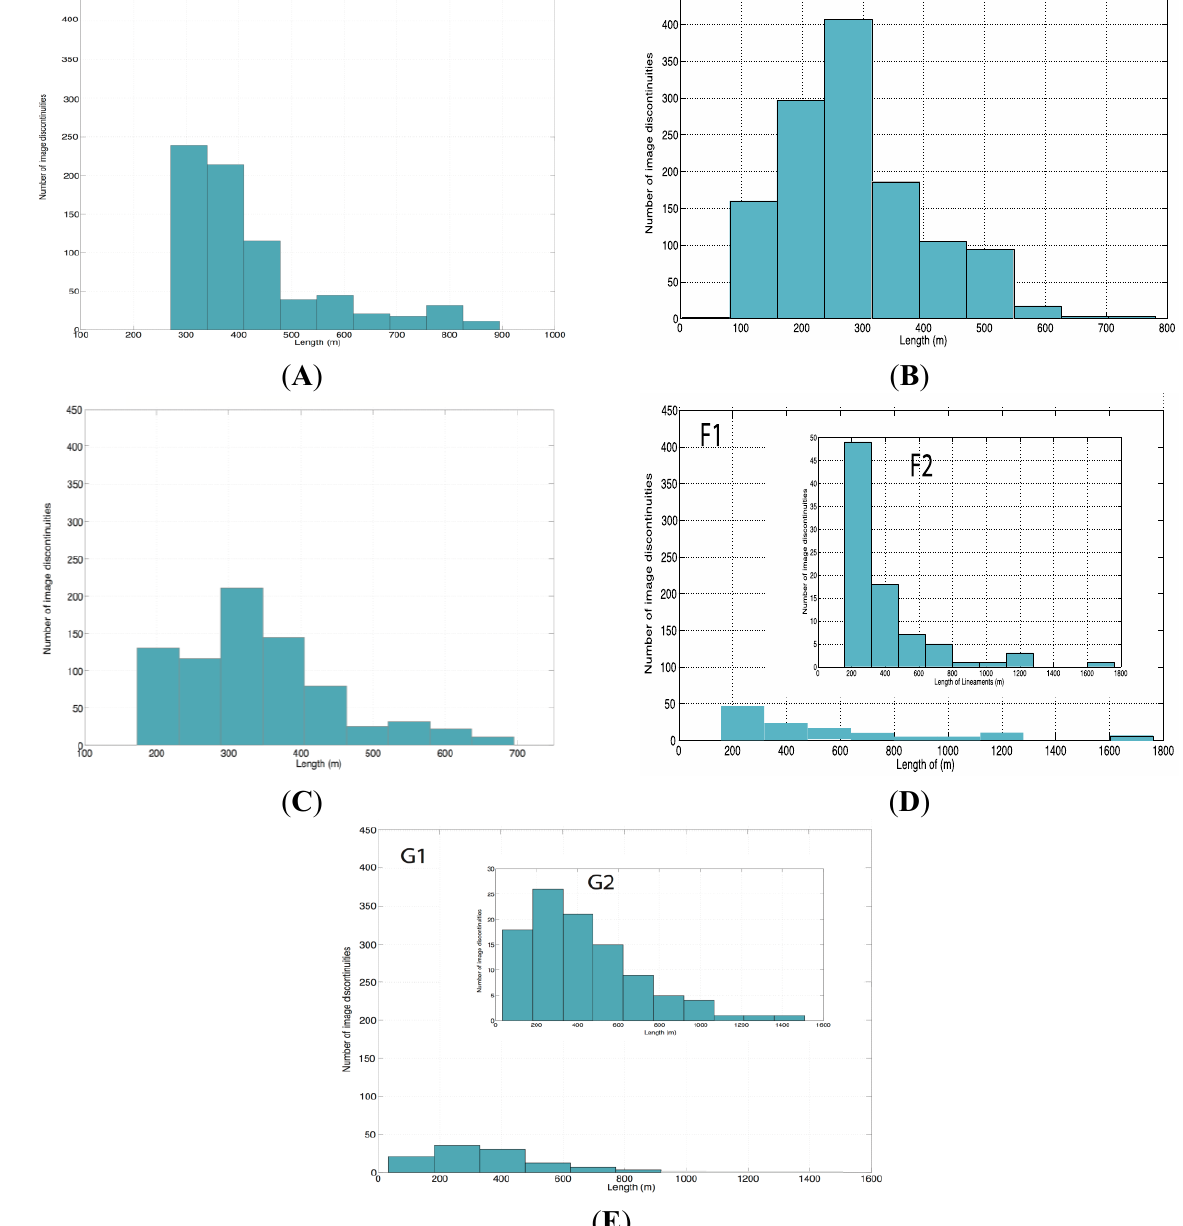
Figure 14. ( A – C ): Frequency of extracted discontinuities length by polynomial interpolation method from Sobel, LOG and Canny data sources, respectively; ( D-F1) : Frequency of length for automatically (PCI) extracted discontinuities; ( D-F2 ): Enlarged image of ( D - F1 ). ( E-G1 ): Frequency of length for manually extracted discontinuities; ( E-G2 ): Enlarge the image of